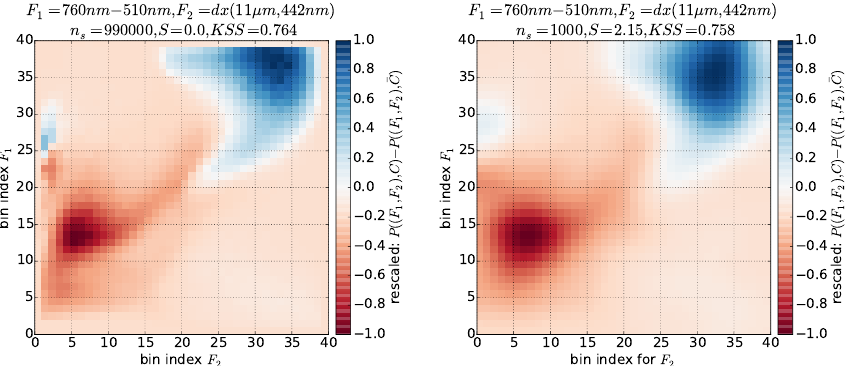
Figure 4. Similar to Fig. 3 but for a different set of features and a different Gaussian smoothing factor of 2 . 15. This set of features includes the MERIS Oxygen A band absorption